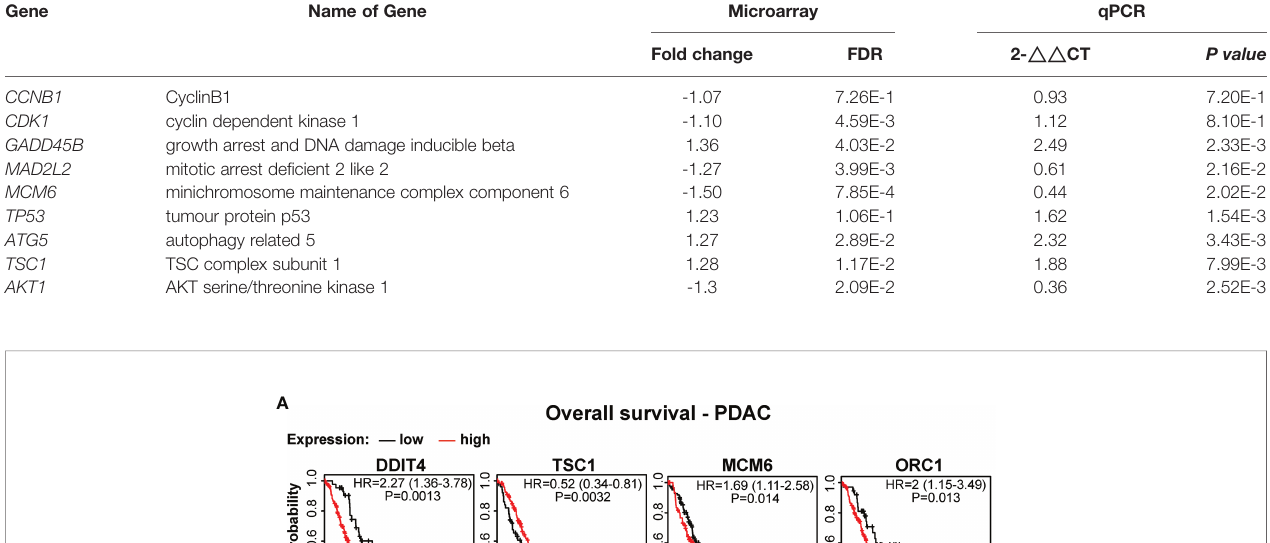
TABLE 2 | Comparison of RT-qPCR and microarray results. Gene